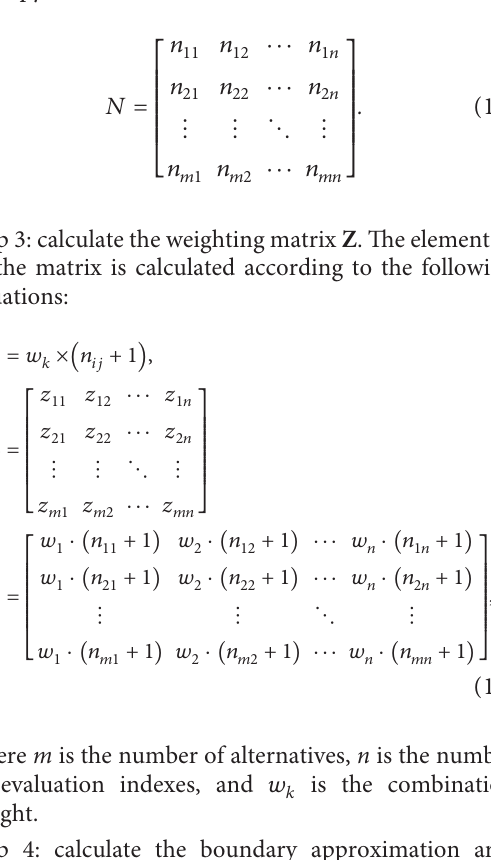
Step 2: due to the difference in the unit and value of